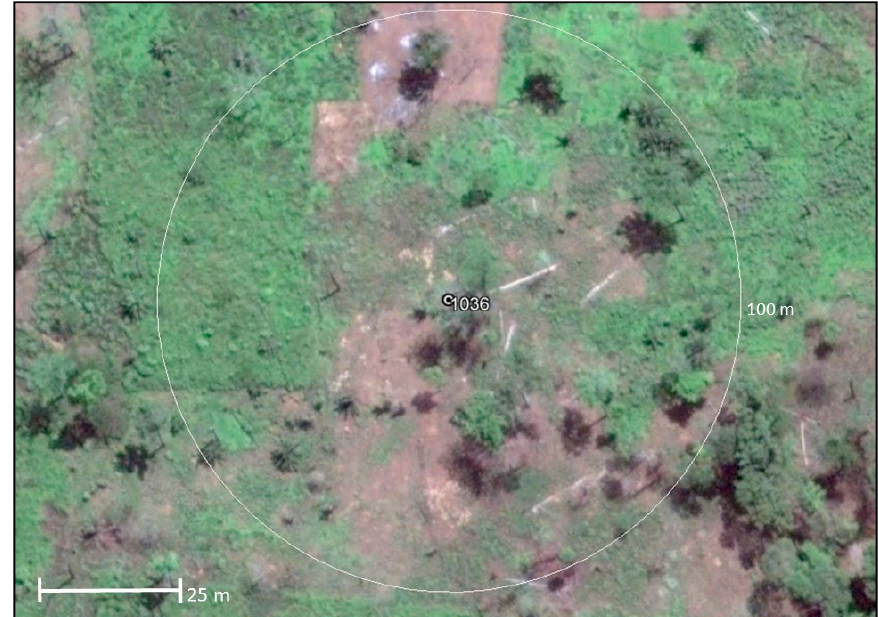
Figure 6. Sample 1036: The photo-interpretation of this point is labeled as “clearing”, although visualizing the 100 m radius circular buffer area aids the interpretation by adding context to the sample point. In this instance a number of shifting cultivation mosaic land cover types are observed, such as: clearings, active and fallow fields, and secondary forest (3°4 ′ 52.34 ″ N, 20°38 ′ 17.95 ″ E).